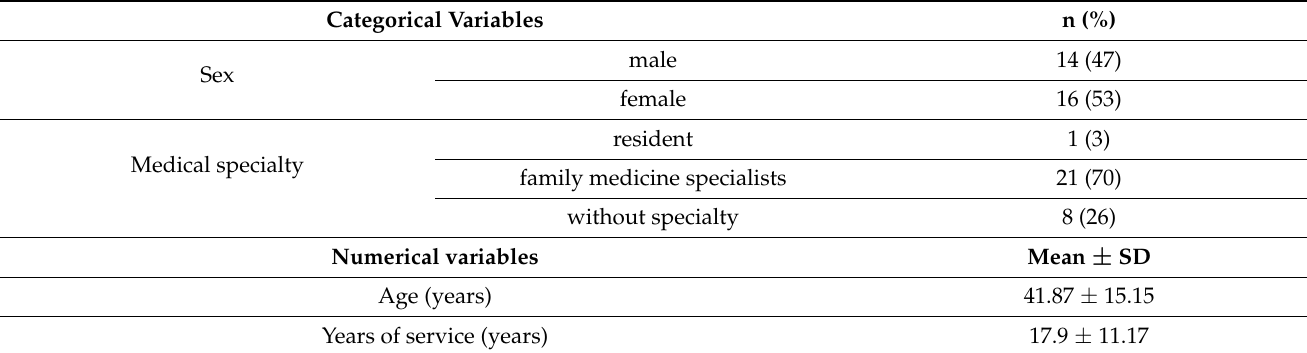
Table 1. Baseline characteristics of physicians involved.